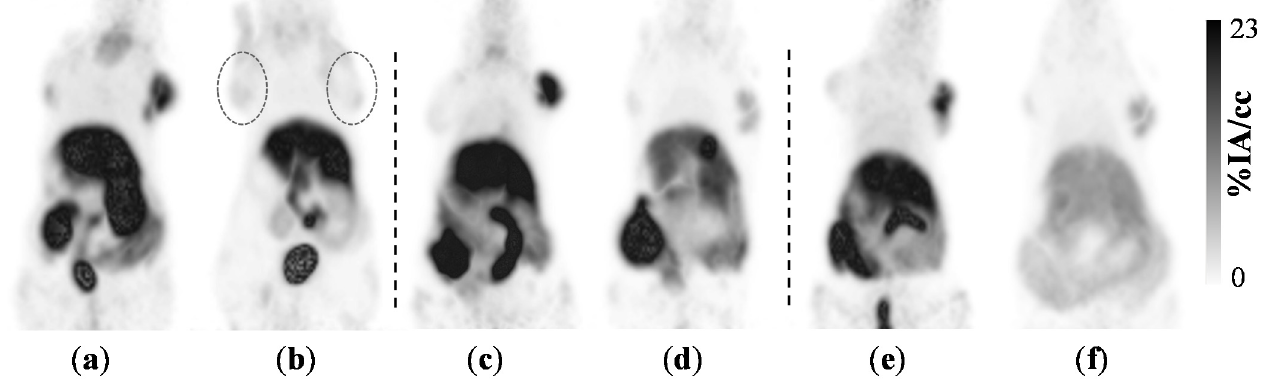
Figure 3. Representative maximal intensity projections of 64 Cu-DOTHA 2 -PSMA PET in LNCaP tumor-bearing mice without ( a , c , e ) and with ( b , d , f ) the co-injection of nat Cu-DOTHA 2 -PSMA as a blocking agent. ( a , b ) Average frames from 40 to 60 min p.i. from dynamic scans; ( c , d ) 4 h p.i. 20 min static scan; ( e , f ) 24 h p.i 1 h static scan. The 1 mm 3 3D Gaussian smoothing was applied for presentation only. Tumors are identified by circles in ( b ) only.